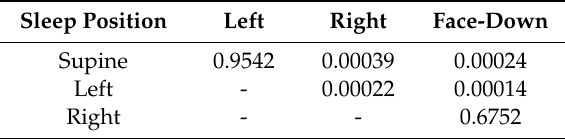
Table 7. Pair-wise p value from Wilcoxon rank sum test.